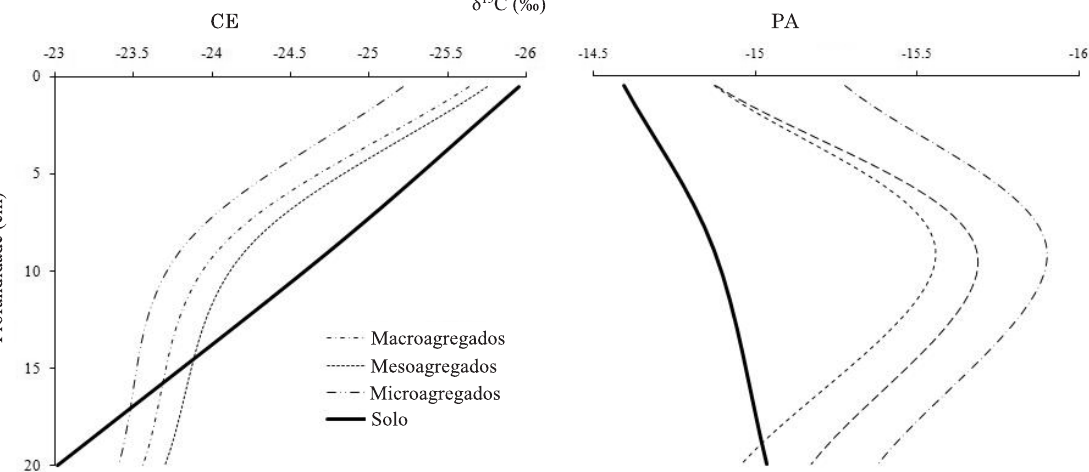
Figura 3. Composição isotópica do carbono do solo total e em diferentes classes de agregados sob Cerradão (CE) e pastagem (PA) em um Latossolo Vermelho, em Rio Verde,